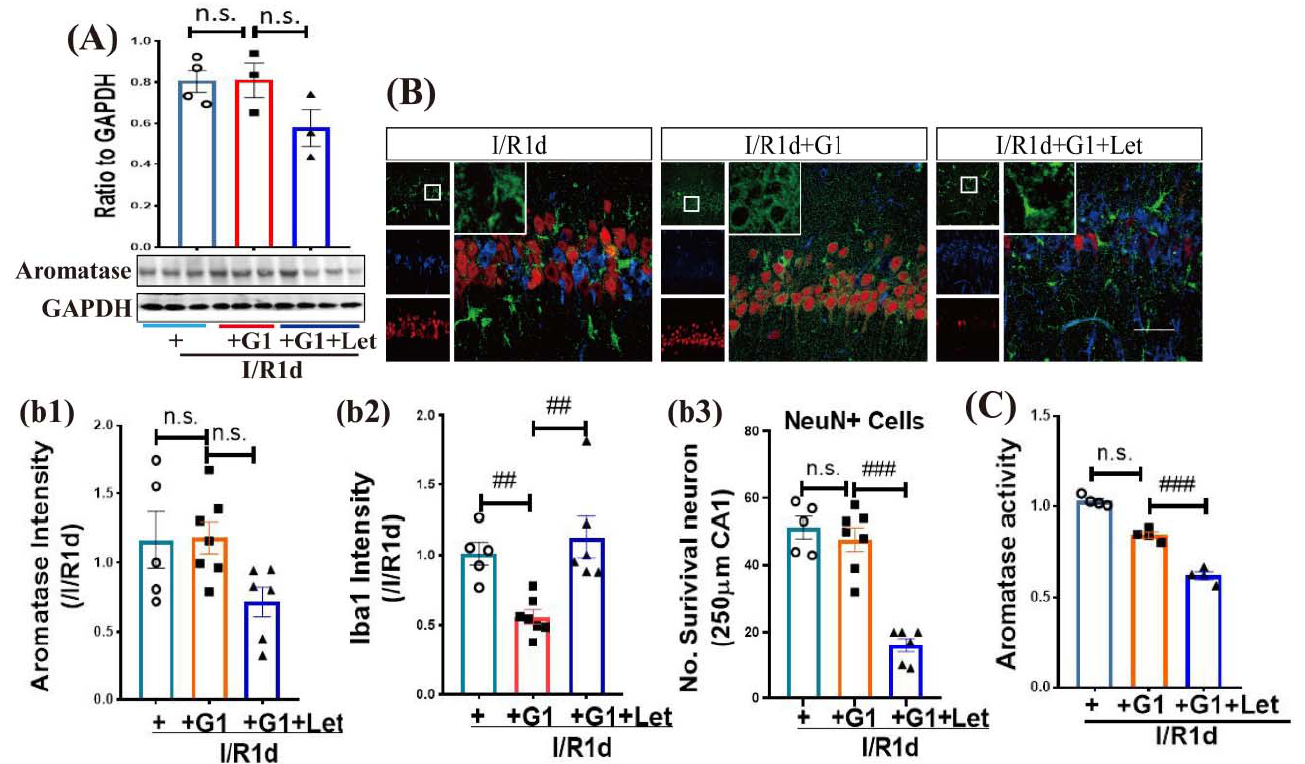
Figure 5. The anti-inflammatory effect of G1 after global cerebral ischemia was dependent on BDE2 in the ovariectomized rat hippocampal CA1 region. ( A ) Hippocampal CA1 samples from the one day of reperfusion (I/R1d), I/R1d+G1, and G1+Let groups were subjected to Western blot analysis of Aro. Quantitative data are expressed as the ratios to GAPDH. ( B ) Representative photographs of triple immunofluorescence staining of Aro (green), Iba1 (blue), and NeuN (red). Quantitative analysis results of fluorescence intensity of Aro ( b1 ) and Iba1 ( b2 ) staining in the hippocampal CA1 region, expressed in arbitrary units as ratios to the I/R1d group, were obtained. ( b3 ) The number of surviving neurons was quantified by counting the number of NeuN-positive neurons per 250 µ m segment in the medial CA1 pyramidal cell layer. ( C ) The enzyme-linked immunosorbent assay analysis showed the effect of Let on aromatase activity with or without G1 treatment. Data are represented as the means ± SEs from five to seven independent samples ( n = 3–5 in each group). ## p < 0.01, and ### p < 0.001. n.s. no significance. Scale bar, 50 µ m. Magnification, 40 × . Aro, aromatase; Let, letrozole; I/R, ischemia reperfusion; ns, not significant; Iba1, Ionized calcium binding adaptor molecule 1. White Box in subfigure B, GPER, G-protein-coupled estrogen receptor